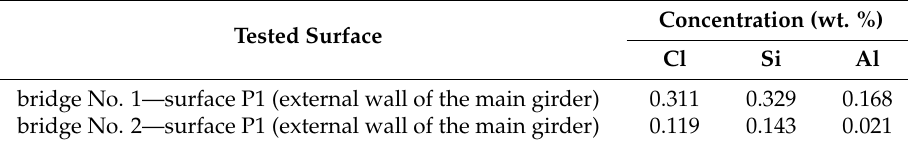
Table 5. Composition analysis of corrosion products after one-year exposure—comparison of both bridges.